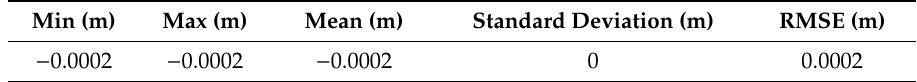
Table 19. Statistical values of the residuals for the East coordinates after reprojection from WGS84 ellipsoidal coordinates to OSPM / WGS84.